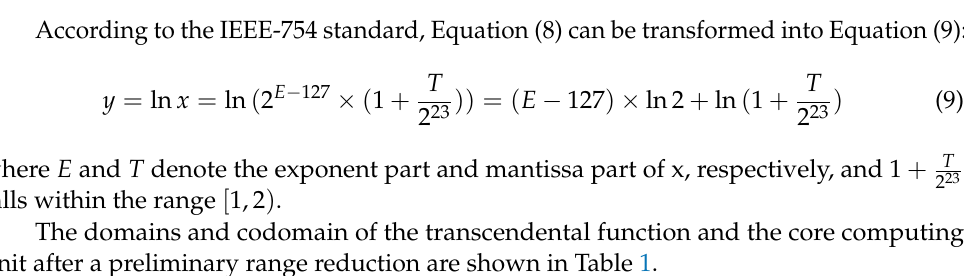
Table 1. The domains and codomain of the transcendental function and the core computing unit. Transcendental Function